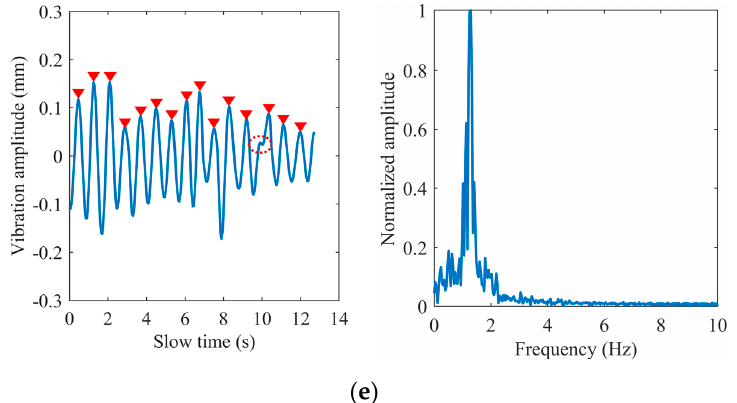
Figure 10. Subject #1: ( a ) extracted phase; ( b ) phase difference; ( c ) the impulse noise removal; ( d ) breathing waveform; ( e ) heart waveform.